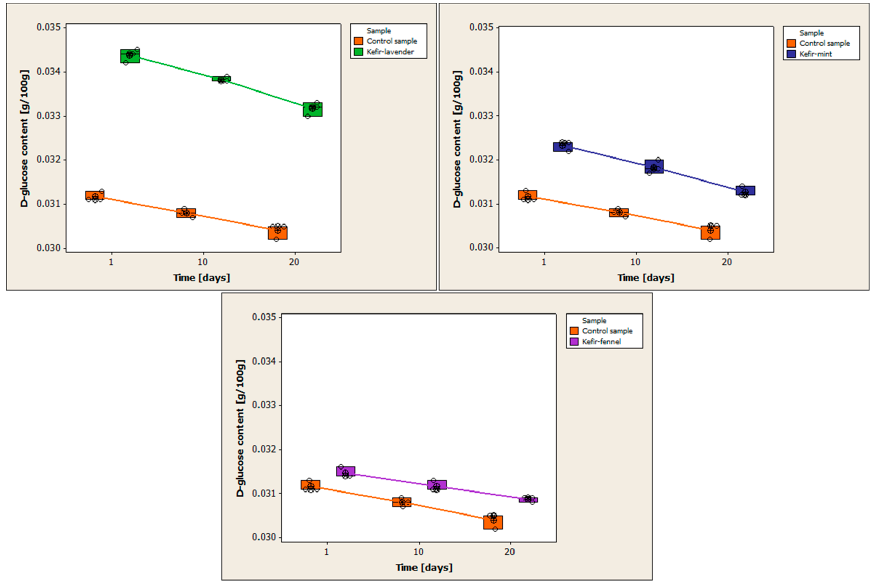
Figure 5. Comparative variation of D-glucose content determined by the enzymatic method in kefir samples with encapsulated volatile oils and the control sample .